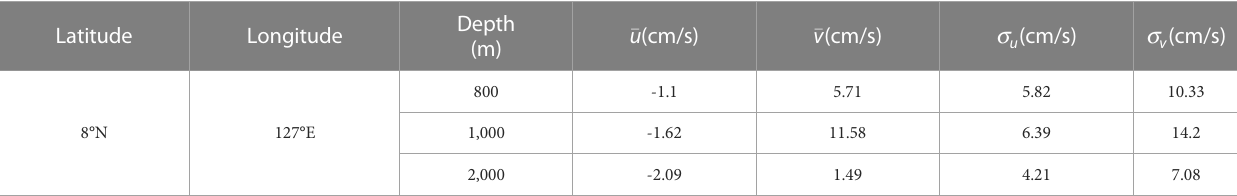
TABLE 1 Velocity statistics from mooring data at different layers in terms of mean values and standard deviation.